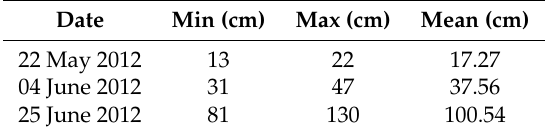
Table 2. The measurement date and Min, Max, Mean of canopy